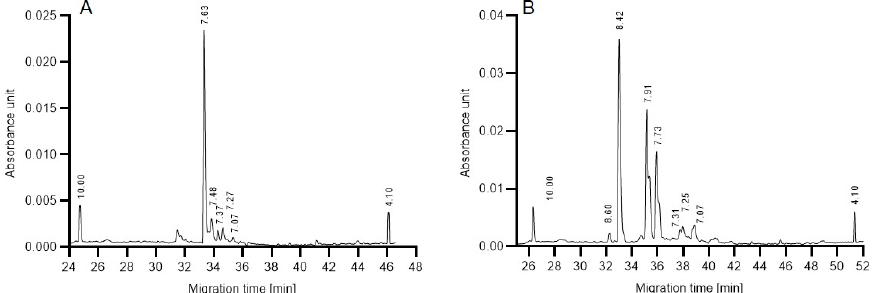
Figure 5. Capillary isoelectric focusing analysis of the in-house produced 6His-tagged ( A ) and a commercial ( B ) PNGase F enzymes. Numbers above the peaks represent the corresponding pI values. Separation conditions: 20 cm effective capillary length (30 cm total length, 50 μ M ID, NHCO coating); applied focusing and mobilization electric field strengths were 25 kV and 30 kV, respectively. pI markers: 4.1 and 10.0. Separation temperature: 20 °C. The sample was mixed into the Master Mixture and introduced by applying 25 psi for 99 s, i.e., to completely fill the separation capillary.